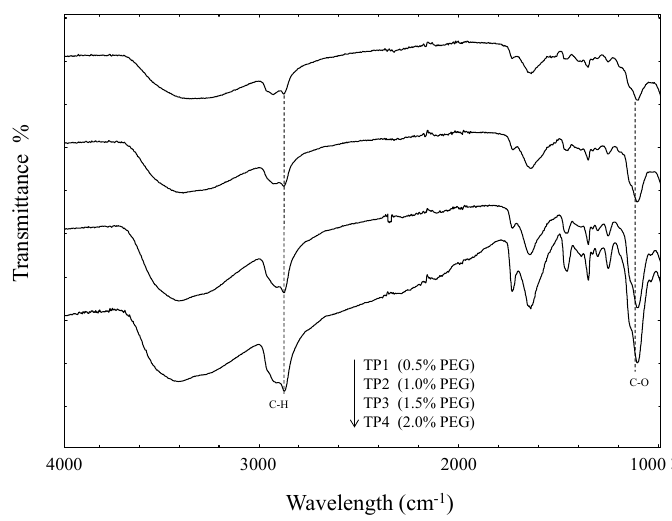
Figure 1. FTIR spectra of different percentages of polyethylene glycol (PEG) in immobilized TiO 2 -PEG.